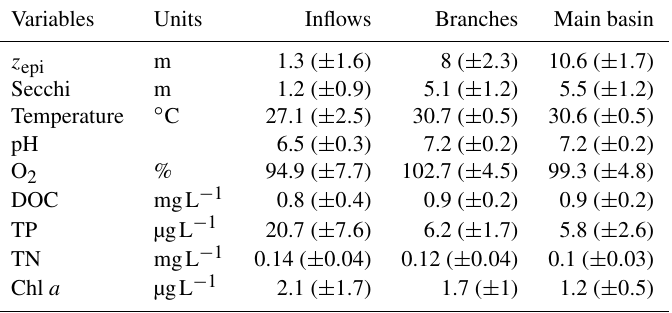
Table 1. Mean ( ± SD) of physical and chemical variables measured at the surface of the three reservoir sections. Variables Units Inflows Branches Main basin z